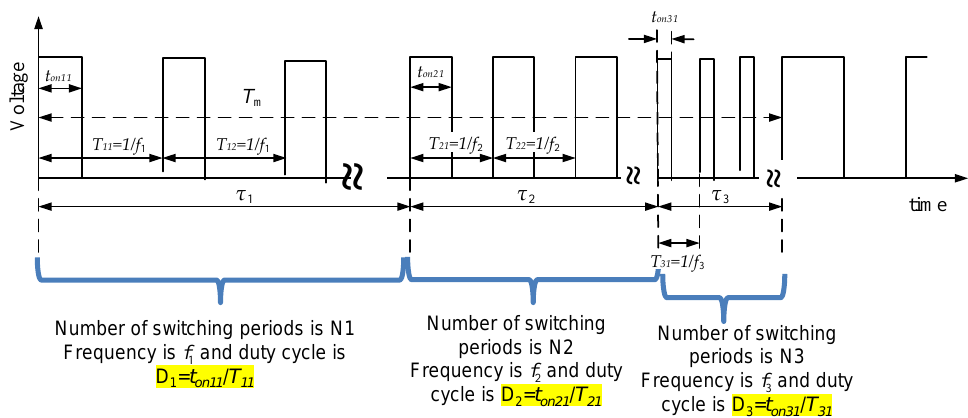
Figure 7. Simplified 3F3D waveform of the inverter control signal used in the experiments. If N1 = N2 = N3 = 6, f 1 = 151.5 kHz, f 2 = 170.6 kHz, f 3 = 190.1 kHz, then f m = 10.6 kHz.